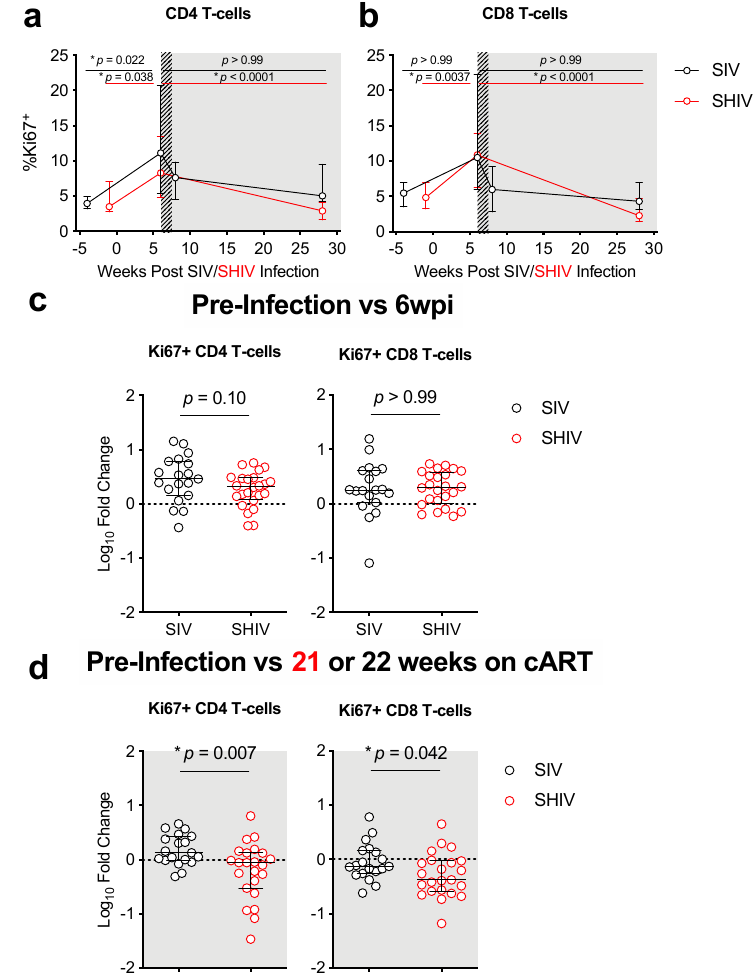
Figure 5. Incomplete viral suppression during cART in SIV-infected macaques is associated with greater gut immune activation. ( a , b ) Immune activation was measured as the percentage Ki67 + of CD4 + ( a ) or CD8 + ( b ) T-cells in the colon as determined by flow cytometry (as described in methods). ( a , b ) Hashed and shaded regions indicate periods of cART treatment for SIV RMs and all animals, respectively. Lines indicate medians with interquartile ranges. Kruskal–Wallis test, adjusted p -values are given. ( c , d ) Log 10 -fold change in immune activation in the colon between pre-infection and acute infection or 21–22 weeks (>5 months) on cART between SIV (black open circles) and SHIV (red open circles). Each dot represents an individual RM with medians and interquartile ranges indicated. The dotted line indicates no change (value of 1). p -values were determined using a Mann–Whitney test, with * p -values ≤ 0.05 considered significant.